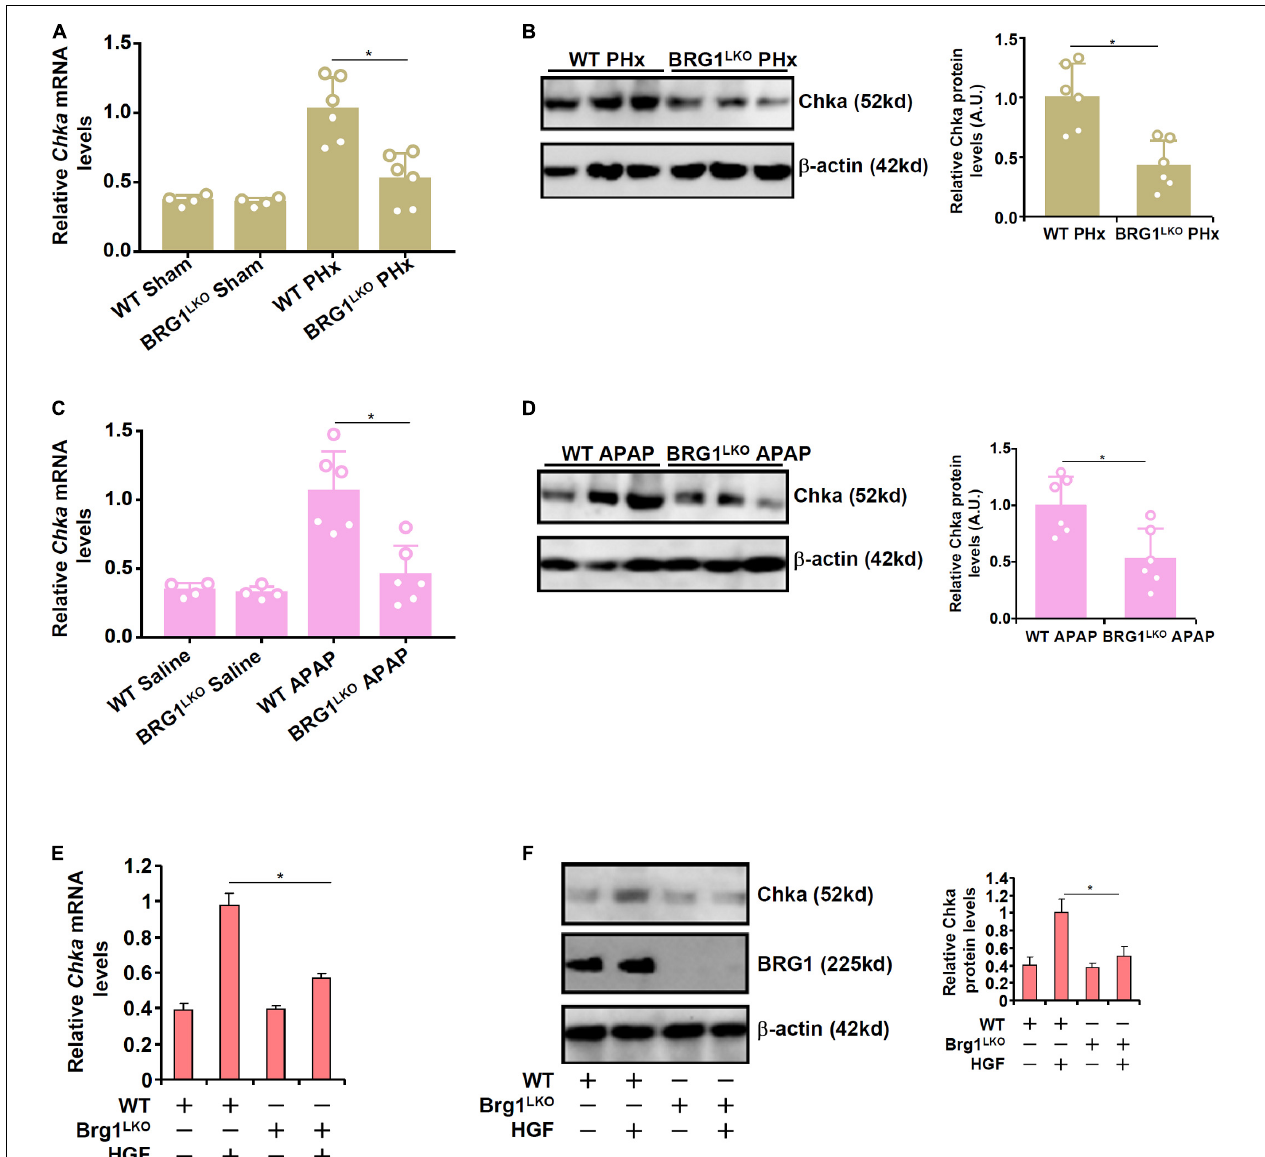
FIGURE 3 | Brahma-related gene 1 deficiency attenuates Chka expression in vivo and in vitro . (A,B) WT and Brg1 LKO mice were subjected to 2/3 PHx and sacrificed 24 h after the surgery. Chka expression levels were examined by qPCR and Western blotting. (C,D) WT and Brg1 LKO mice were injected with APAP (300 mg/kg) and sacrificed 24 h after the injection. Chka expression levels were examined by qPCR and Western blotting. (E,F) Primary hepatocytes were isolated from WT and Brg1 LKO mice and treated with HGF for 24 h. Chka expression levels were examined by qPCR and Western blotting. * p < 0.05.